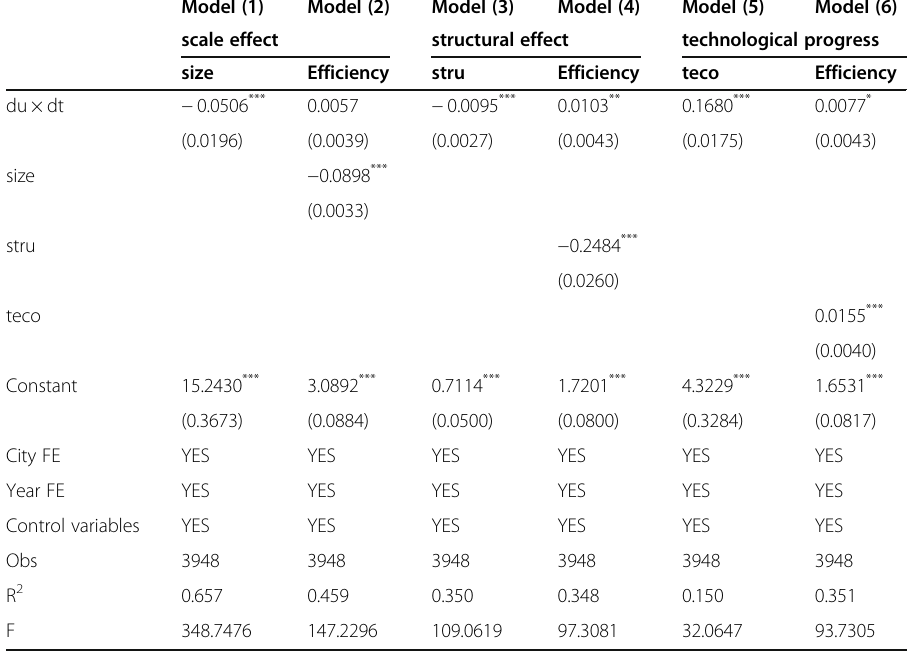
Table 9 The result of the mechanism